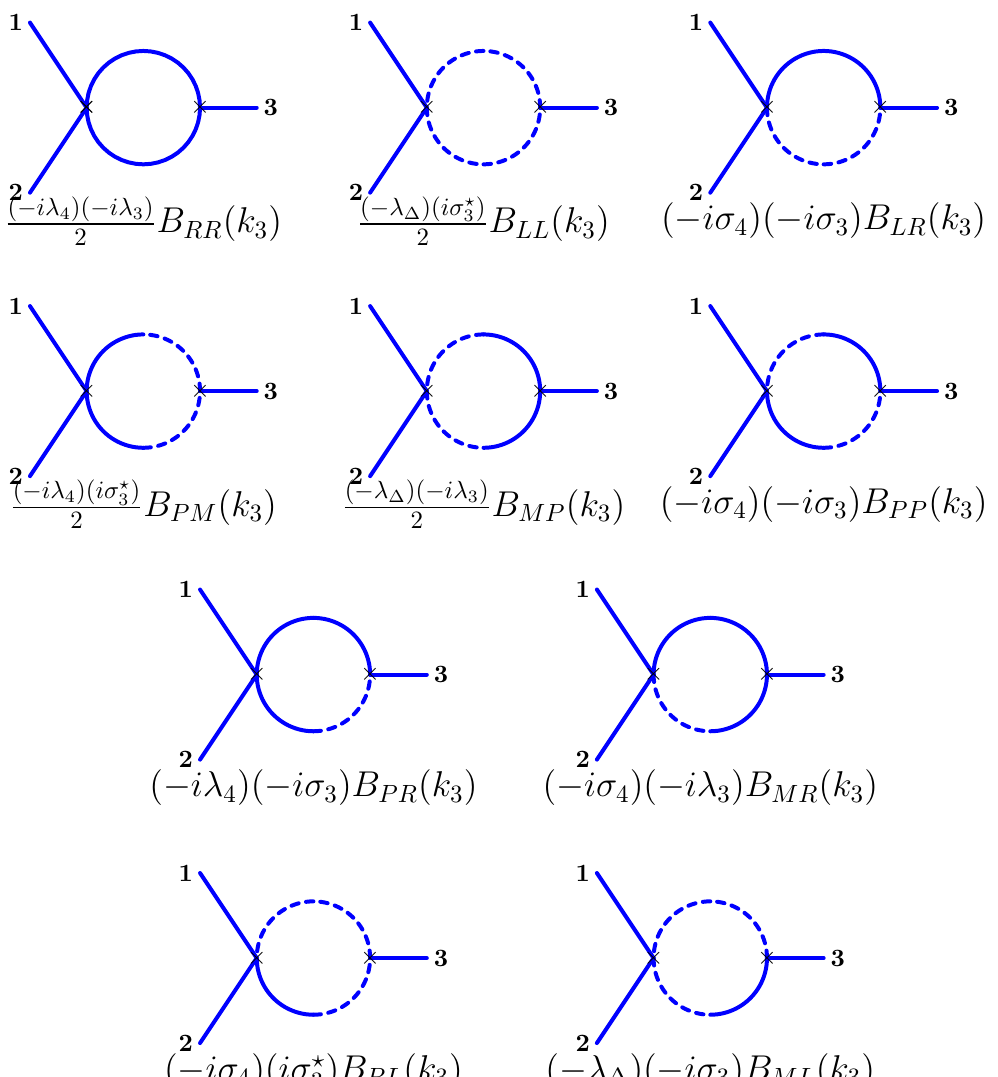
Figure 9. Diagrammatic representation of the Ten 1-Loop Integrals (cid:30) R (cid:30) R cubic (and quartic) couplings, since they are UV (cid:12)nite. 3 Hence, we shall not consider